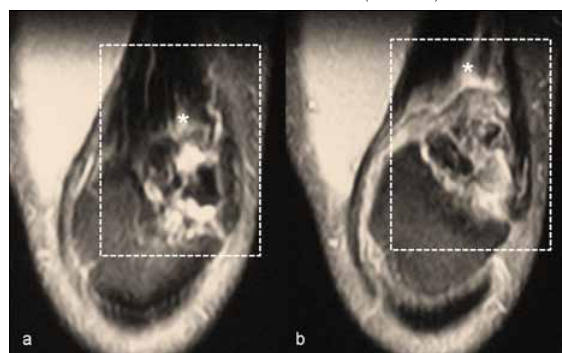
Figure 4. The coronal (a), (b) fat suppressed PD-w MR images verify fragmentation of the superolateral-lateral patellar pole (dashed line) and chronic tendinopathy of the vastus lateralis insertional tendon fibers